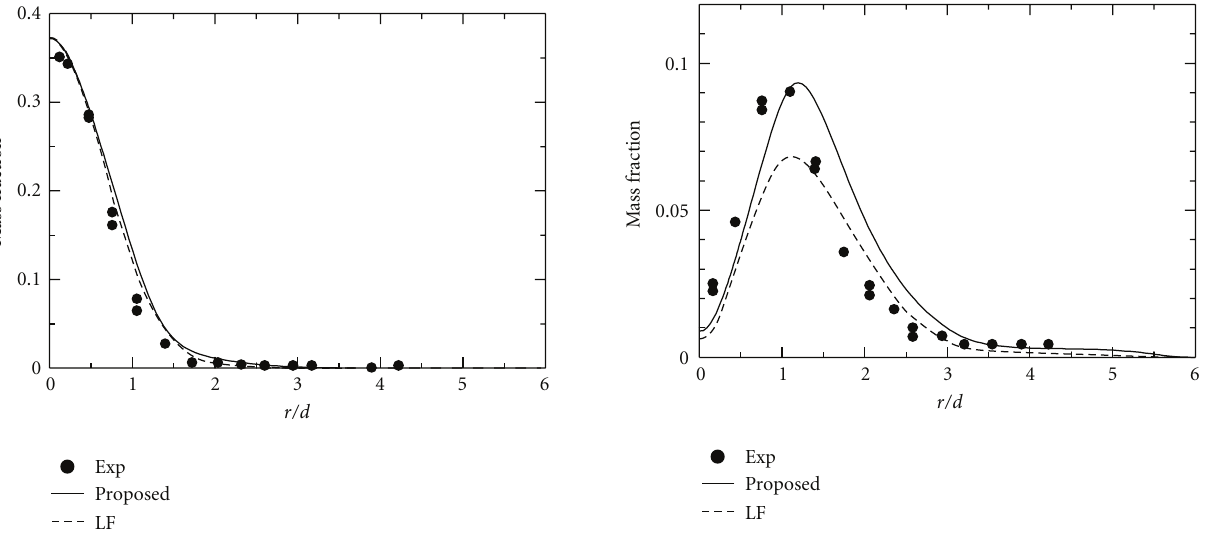
Figure 17: Radial mass fraction of H 2 O at x/d = 10.